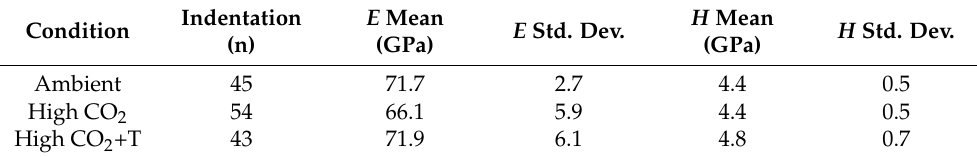
Table 1. Analysis of Young’s Modulus ( E ) and Vickers Hardness ( H ) mean and standard deviation of dead Desmophyllum pertusum samples exposed to various experimental conditions.